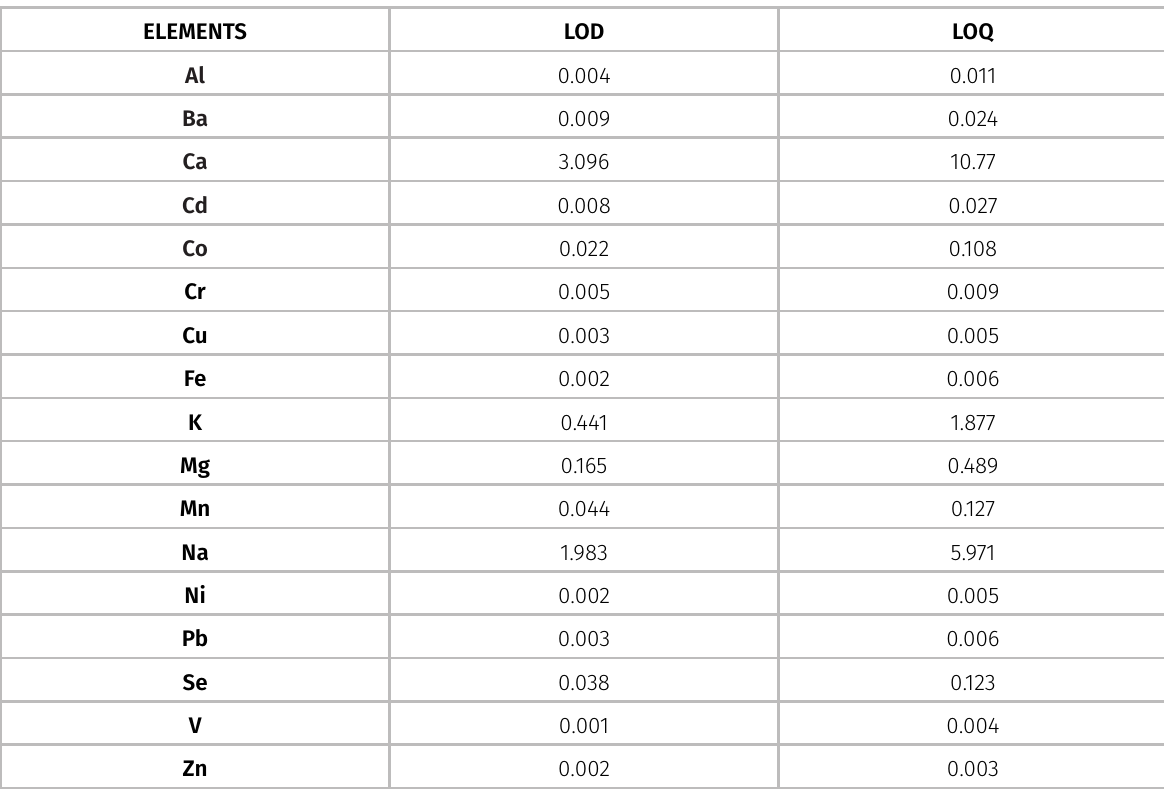
Table II. LOD and LOQ, in µg g -1 , for macro- and microelements determined by ICP OES after the microwave radiation